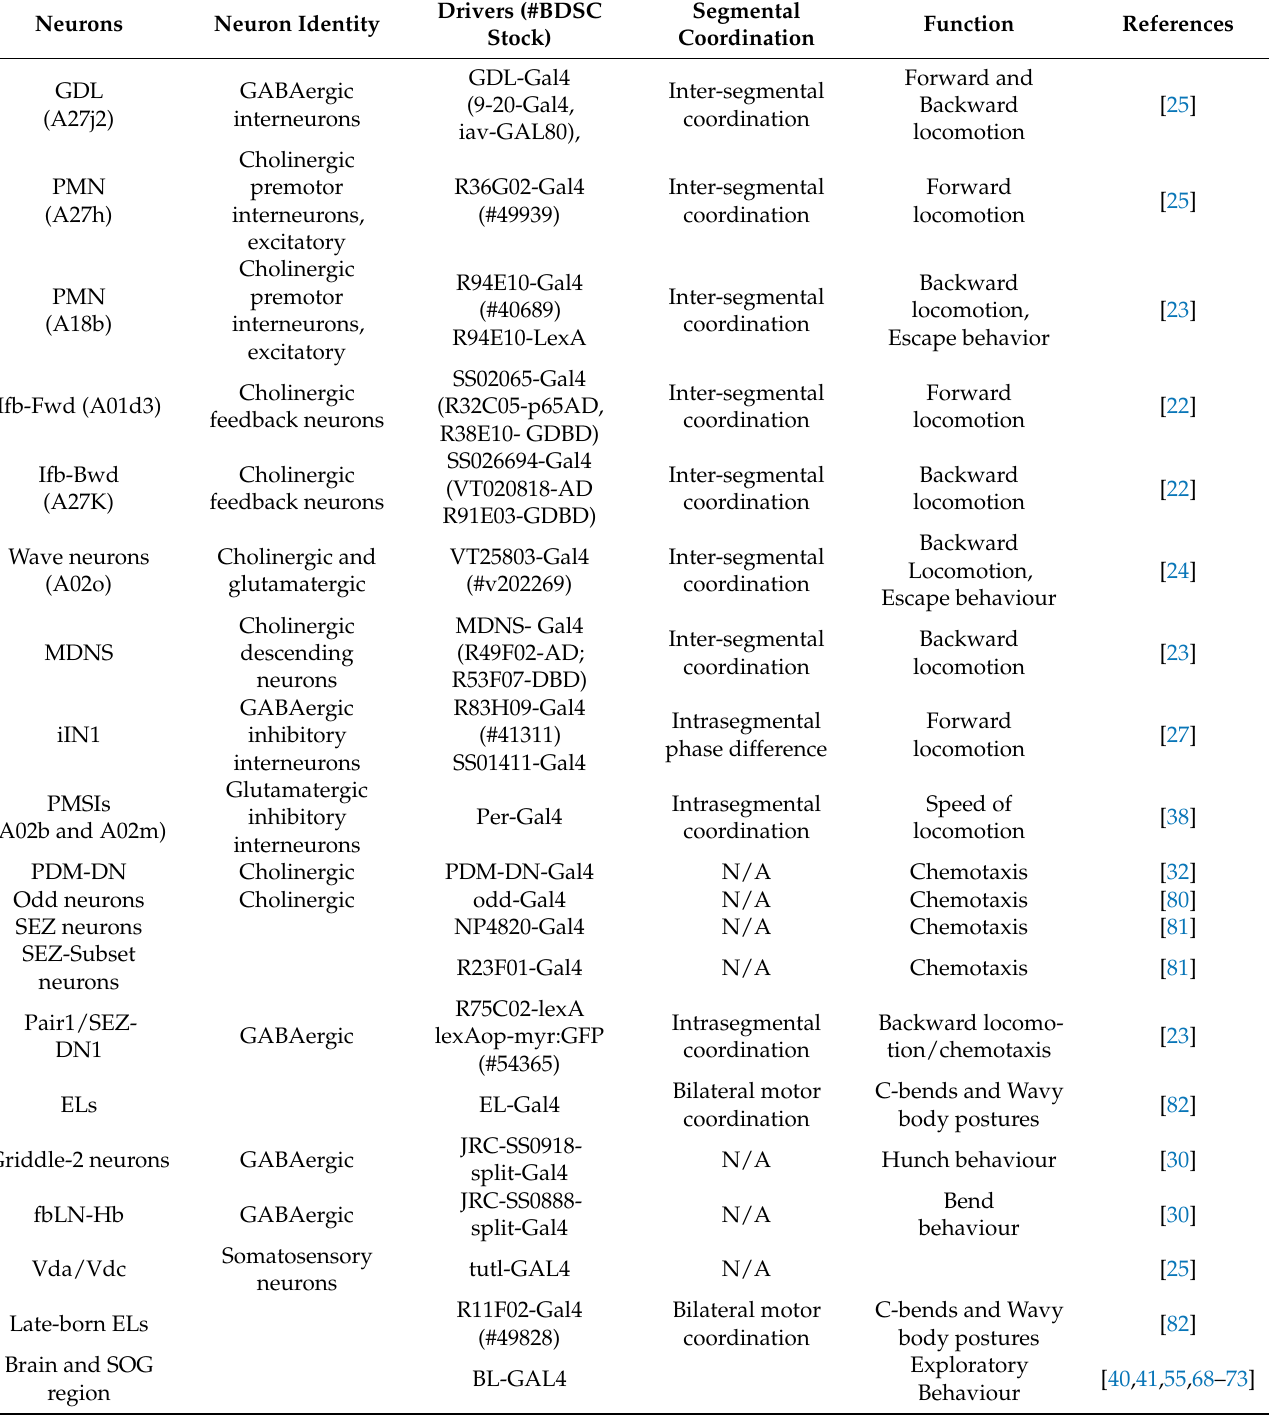
Table 1. List of neurons and associated drivers involved in forward and backward locomotion in Drosophila larvae. The name of the neurons, the associated Gal4 driver available from Bloomington Drosophila Stock Center (#BDSC), the type of segmental coordination, and the published function of these neurons are listed